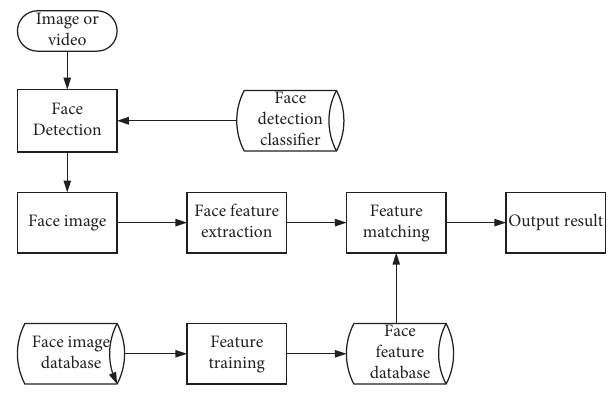
Figure 2: Face recognition system